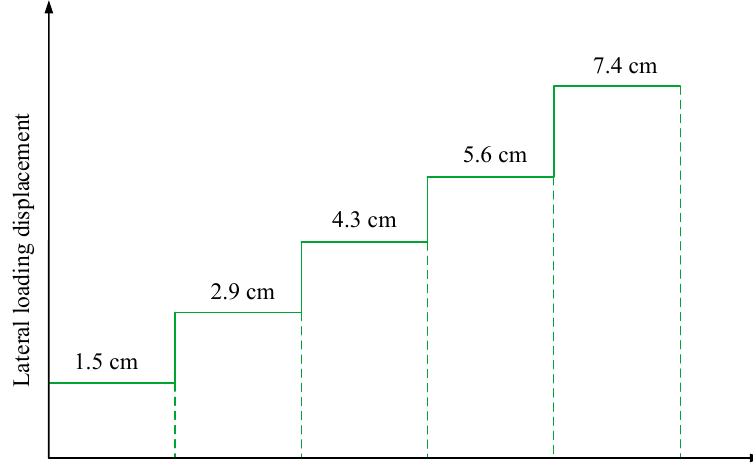
11 of 19 Figure 10. Cubic fitting curve for lateral loading displacement and optical loss. 3.3. Analysis of Measurements of Deep Displacement of Slopes 3.3.1. Measurement Error of Rod-Fiber Coupling Structure During the model experiment, the loading plate compressed the side of the slope model, thereby resulting in an increase in the downslide strength and overall downward movement of the slope model. Lateral loading was applied in stages, as shown in Figure 11. The soil was compressible [36]; therefore, the downslide displacement of the slope toe was smaller than the lateral loading displacement. We consider that the experimental